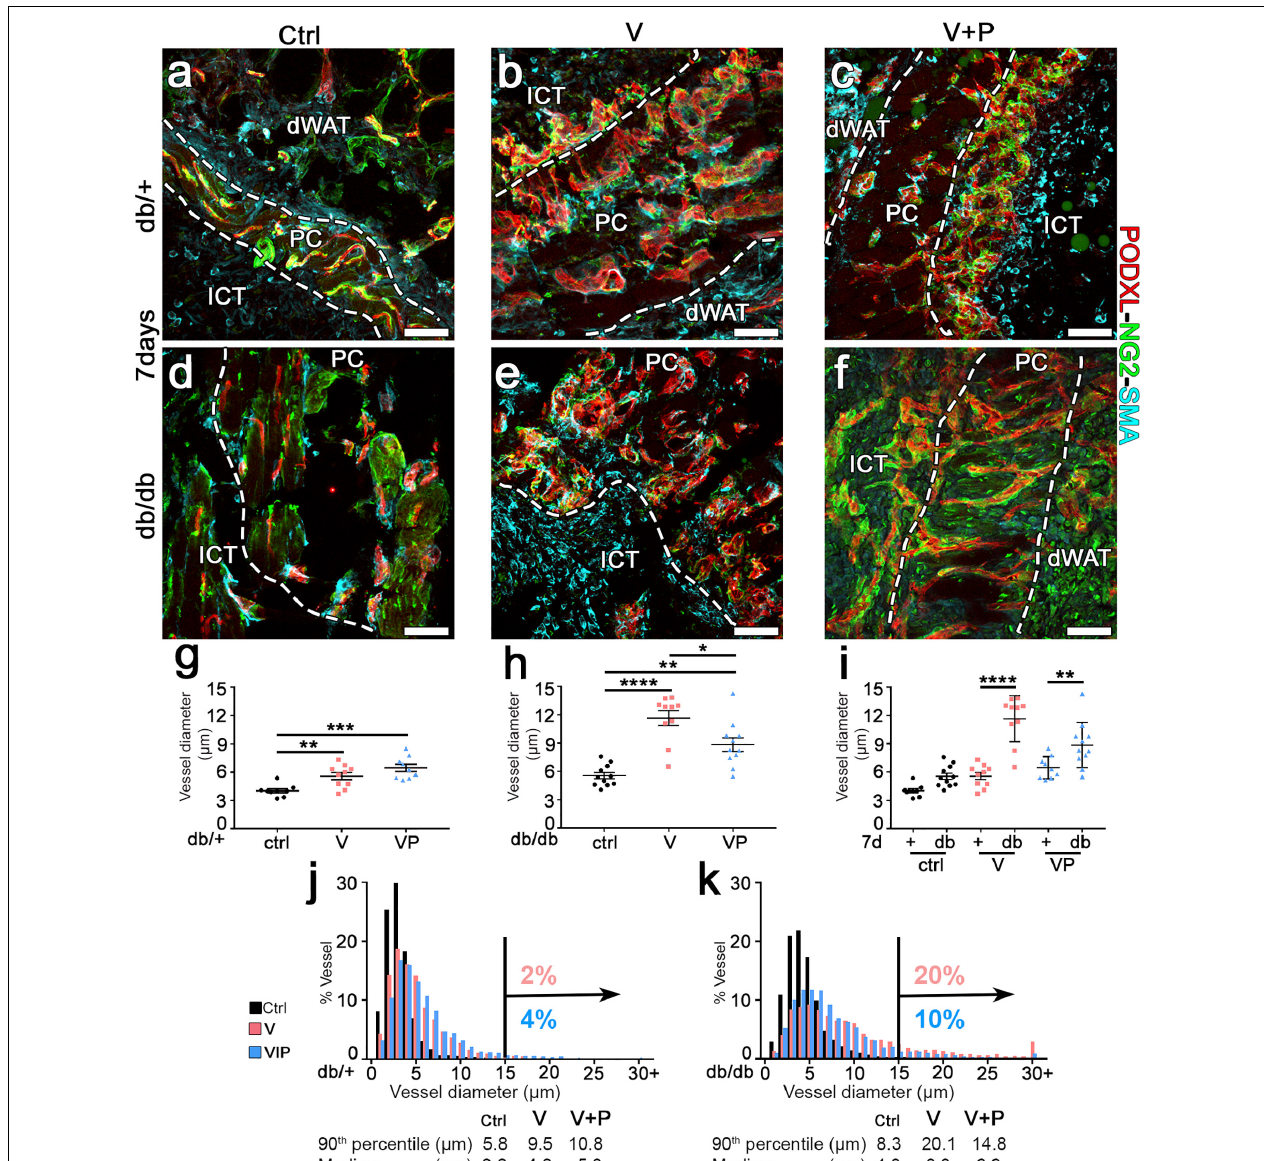
FIGURE 2 | TG-PDGF-BB co-delivery limits the degree of vascular enlargement in diabetic skin. (a–f) Cryosections of dorsal skin of db/+ and db/db mice, harvested 7 days after implantation with fibrin gels decorated with TG-VEGF (V), TG-VEGF and TG-PDGF-BB (VP) or nothing (empty controls, ctrl), were immunostained for podocalyxin (endothelial cells, red), NG2 (pericytes, green), and α -SMA (smooth muscle cells, cyan); dWAT, dermal adipose white tissue; PC, panniculus carnosus; ICT, interstitial connective tissue. (g–k) Vessel diameters (in µ m) were quantified in areas of fibrin implantation in db/+ (+) and db/db (db) mice. Results are shown as mean values of individual samples ± SEM ( g–i ; n = 9–11 samples/group) and as the distribution of vessel diameters over 1- µ m intervals (j,k) . * p < 0.05, ** p < 0.01, *** p < 0.001, **** p < 0.0001 by 1-way ANOVA with Sidak and Tukey multiple comparisons test. Scale bars = 50 µ m in all panels.